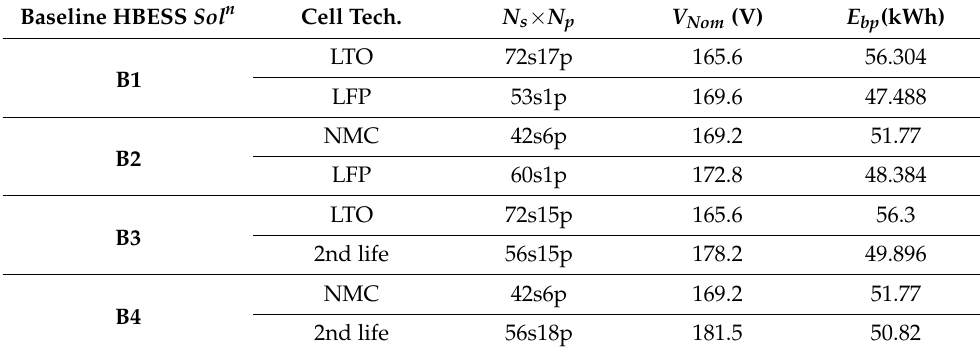
Table 7. Baseline HBESS configurations.